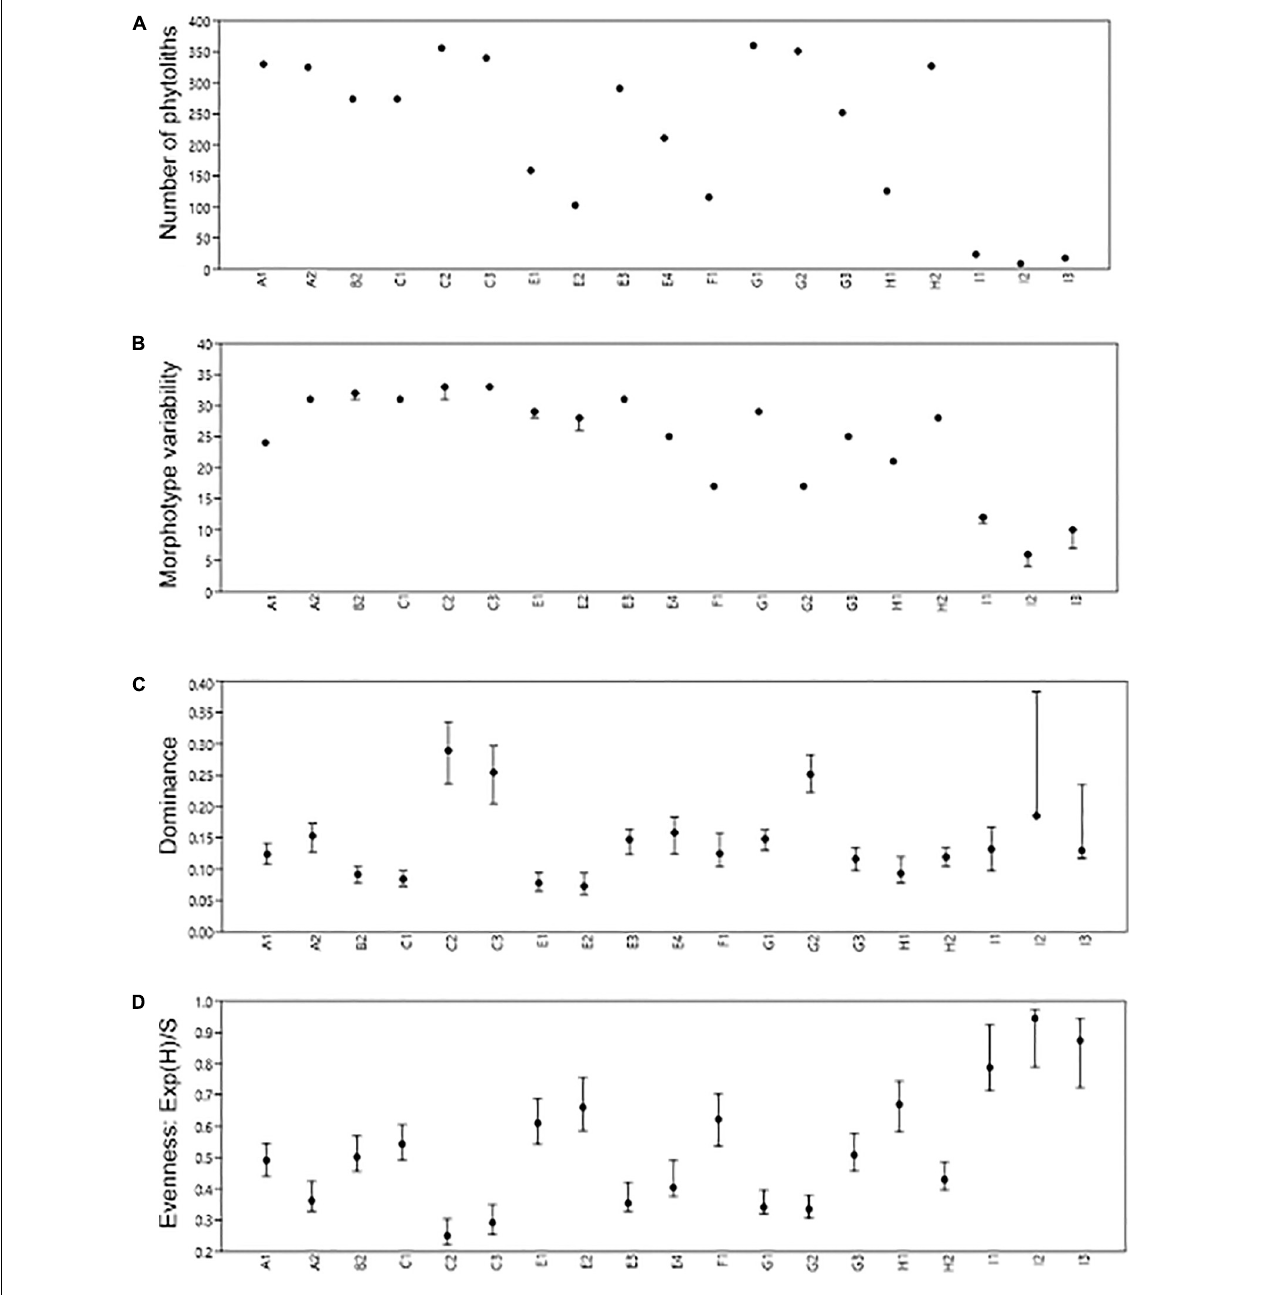
FIGURE 7 | Phytolith richness (A) , variability (B) , dominance (C) , and evenness (D)